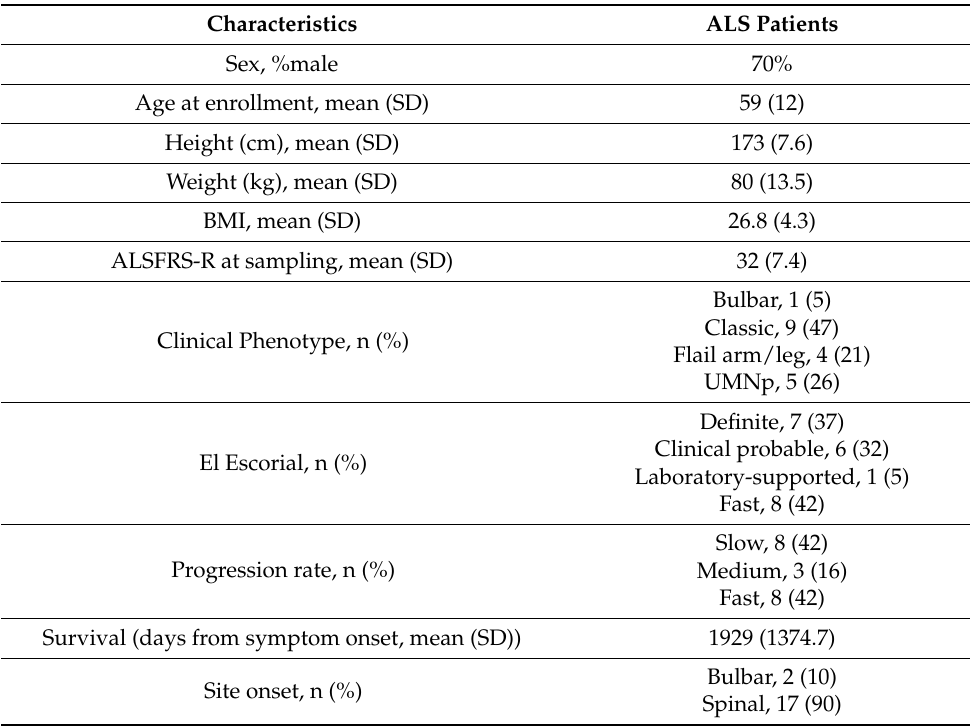
Table 1. Summary of ALS patients’ clinical